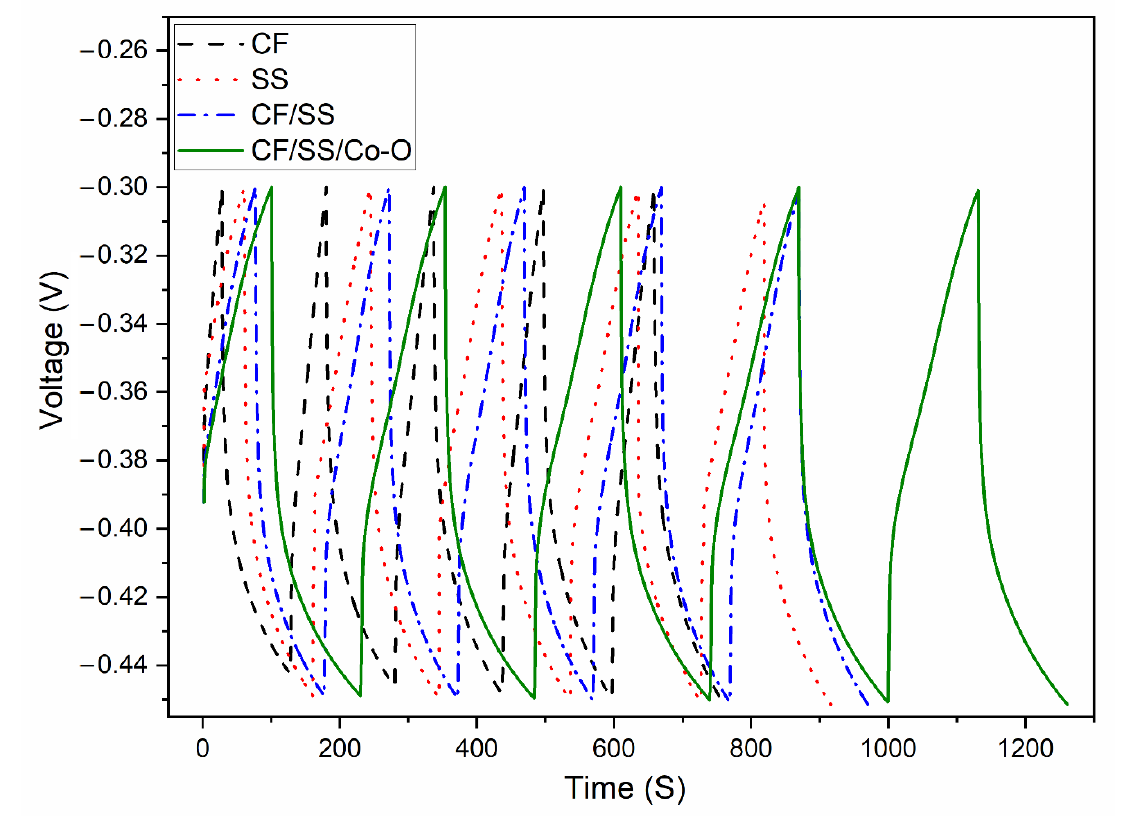
Figure 7. Galvanostatic charge-discharge curves of the MES for all the varied electrode materials.